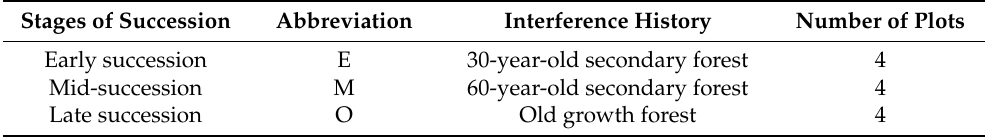
Table 1. Overview of forest dynamic monitoring plots in communities of various successional stages. Stages of Succession Abbreviation Interference History Number of Plots Early succession E 30-year-old secondary forest 4 Mid-succession M 60-year-old secondary forest